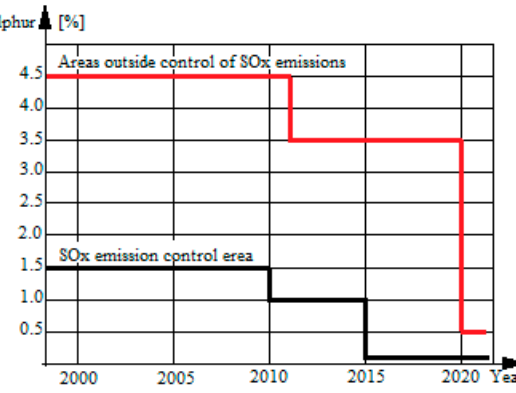
Figure 3. The maximum sulphur content of marine fuel by the MARPOL Convention (author’s drawing based on the data with [6]).